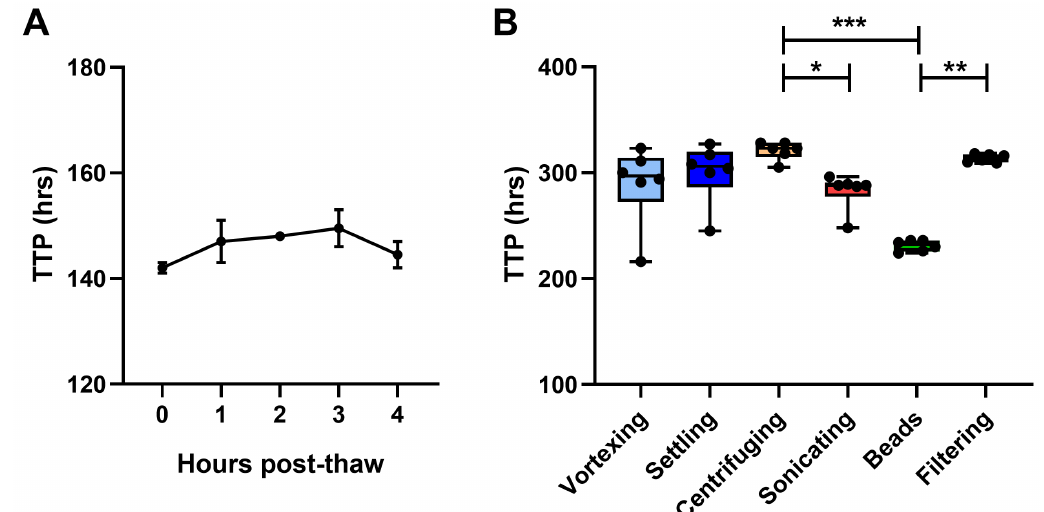
Figure 5. Mycobacterial stock preparation. The effect of A ) time from thawing to inoculation and B ) de-clumping method for mycobacterial stock on BACTEC MGIT time to positivity (TTP) were determined using in-tube co-cultures of human PBMC and BCG Pasteur. For A ), points represent the mean of n=2 duplicate co-cultures with the standard error of the mean (SEM). For B), points represent n=6 individual replicate co-cultures, boxes indicate the median value with the interquartile range and whiskers indicate the minimum and maximum values. A Kruskal-Wallis test was performed with a Dunn’s multiple comparisons test, where * indicates a p-value of <0.05, ** indicates a p-value of <0.01, and *** indicates a p-value of <0.001.